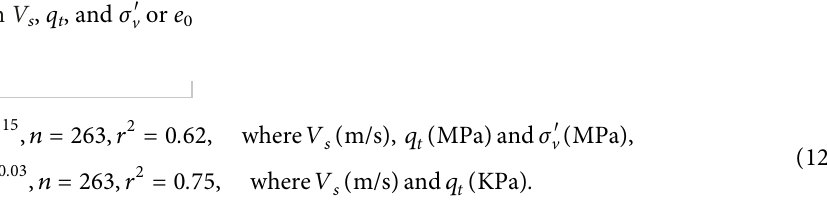
Figure 13 indicates the trend and resulting statistics from multiple regression with data superimposed for comparison.